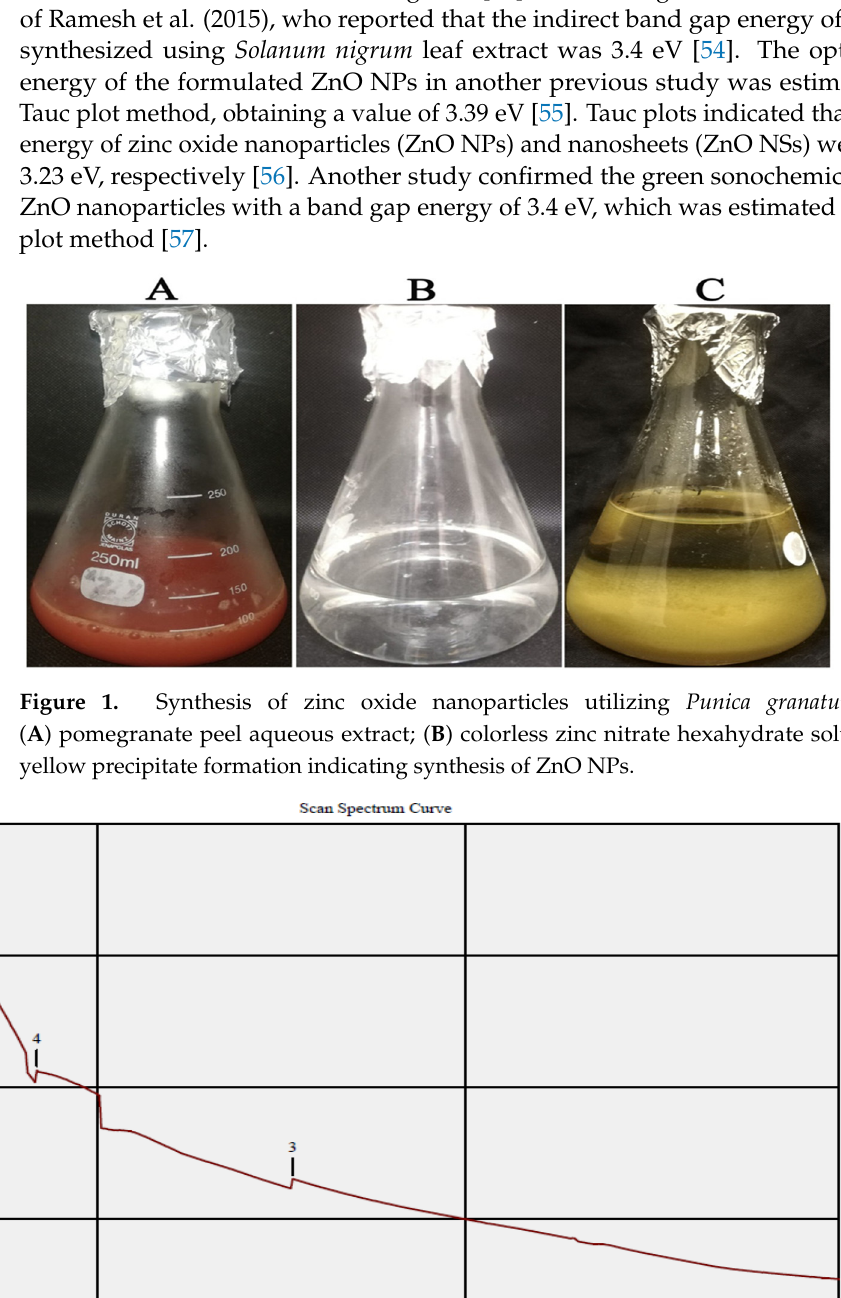
Figure 3. Band gap energy of the biosynthesized ZnO nanoparticles using the Tauc plot method.